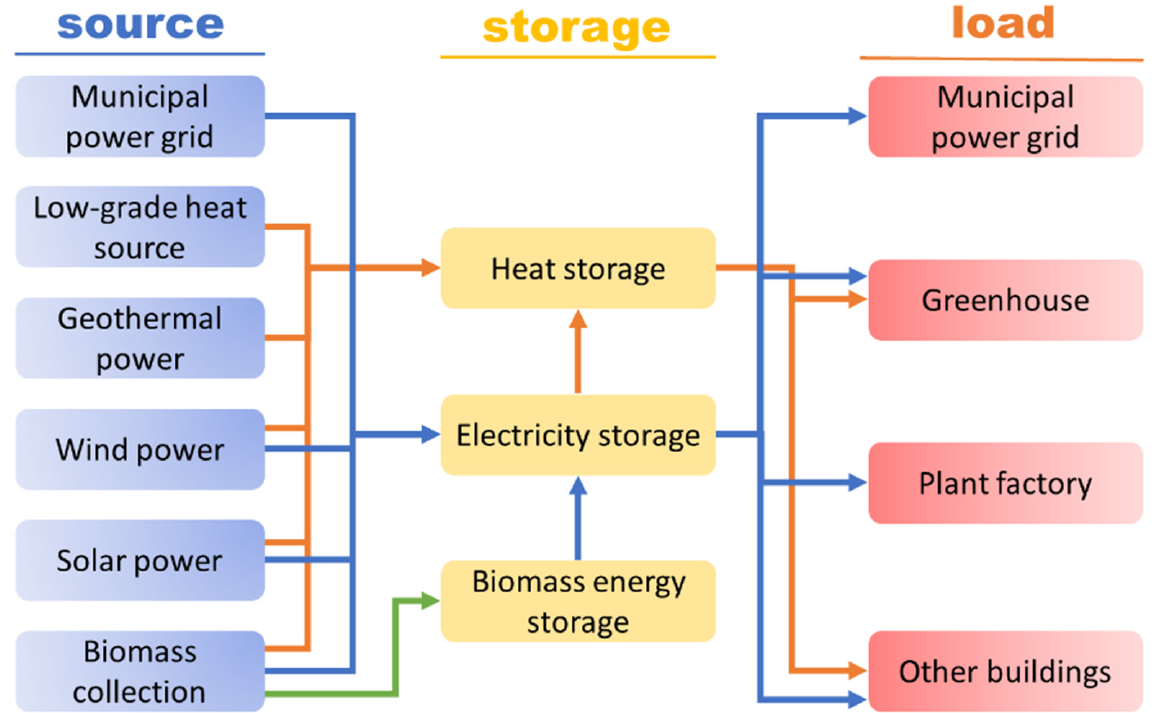
Figure 1. The energy network of CEA industrial precinct.